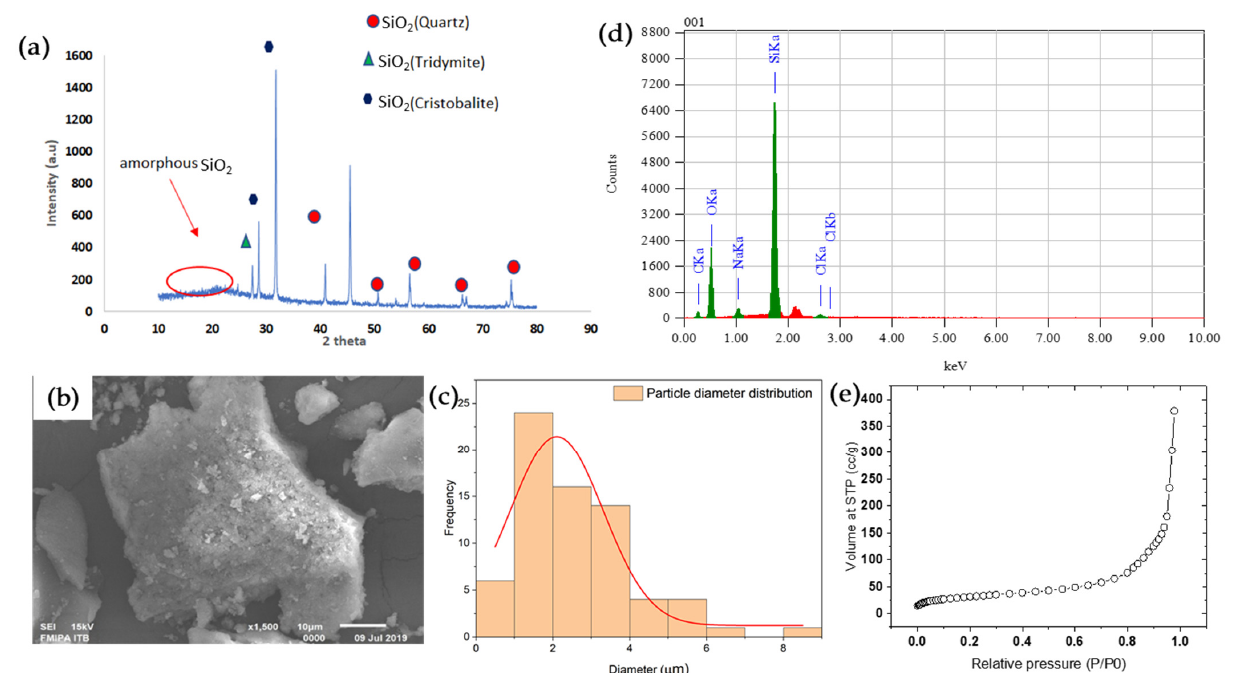
Figure 2. XRD pattern ( a ), SEM image ( b ), particle size distribution ( c ), EDS spectra of rice husk- derived silica particles ( d ), and BET isotherm curve of N 2 adsorption onto the rice husk-derived silica particles ( e ). STP, standard temperature and pressure.